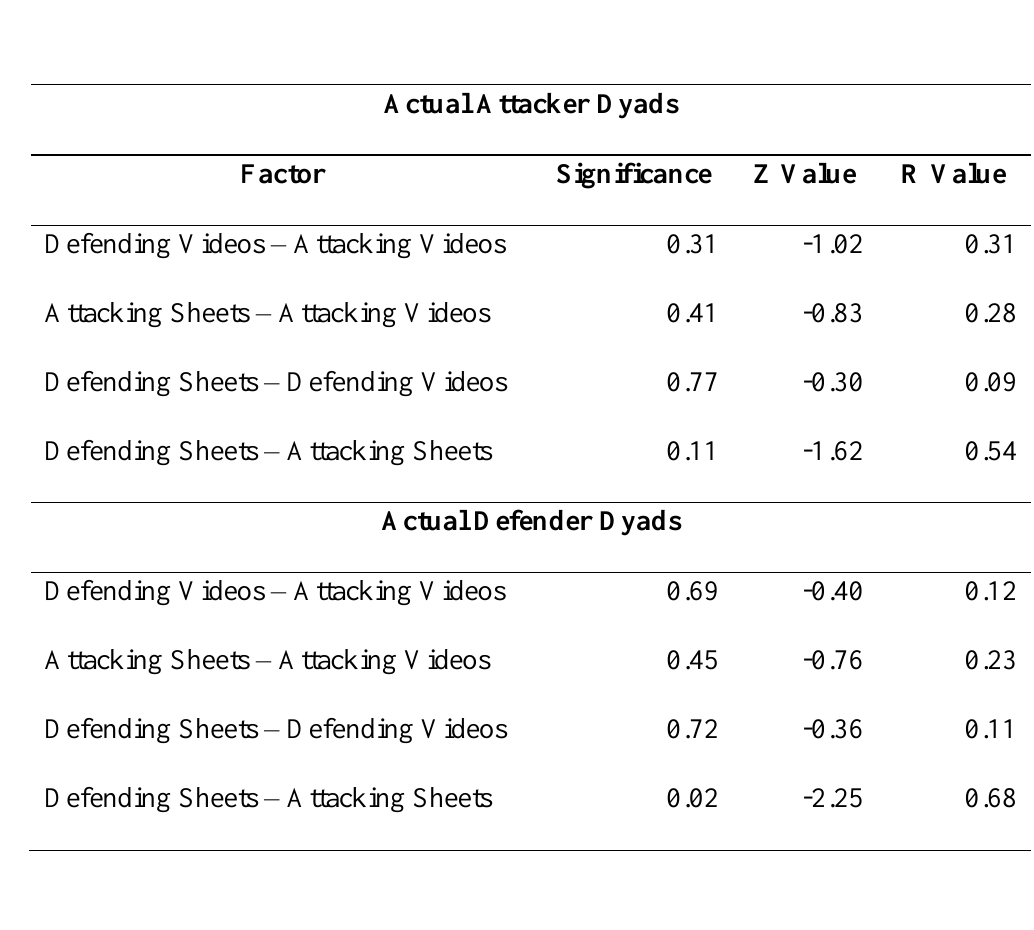
Table 8.7 – Comparisons between Attackers and the Defenders